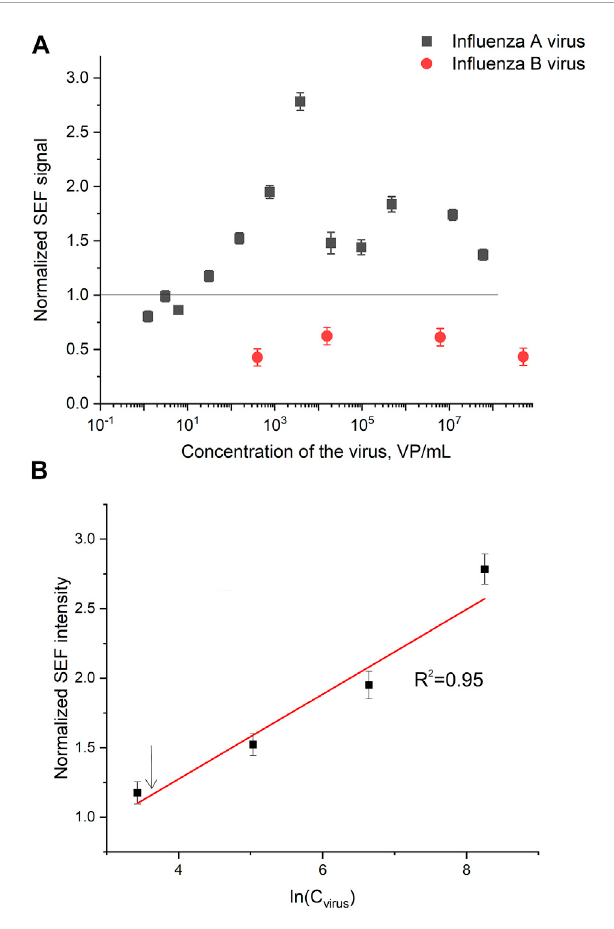
A concentration dependence of a normalized surface-enhanced fl uorescence spectrum intensity of signal from Cyanine-3 reporter on the concentration of in fl uenza A virus and in fl uenza B virus (A) . The part of the dependence with monotonous increase of the signal was used to calculate the limit of detection that is indicated by an arrow (B)